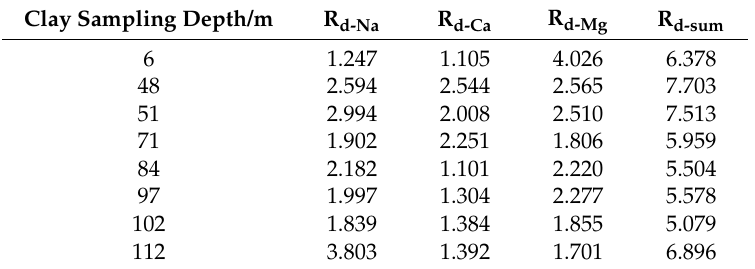
Table 5. The retardation coefficient of Na + , Ca 2+ and Mg 2+ in groundwater in cohesive soils of different depths.